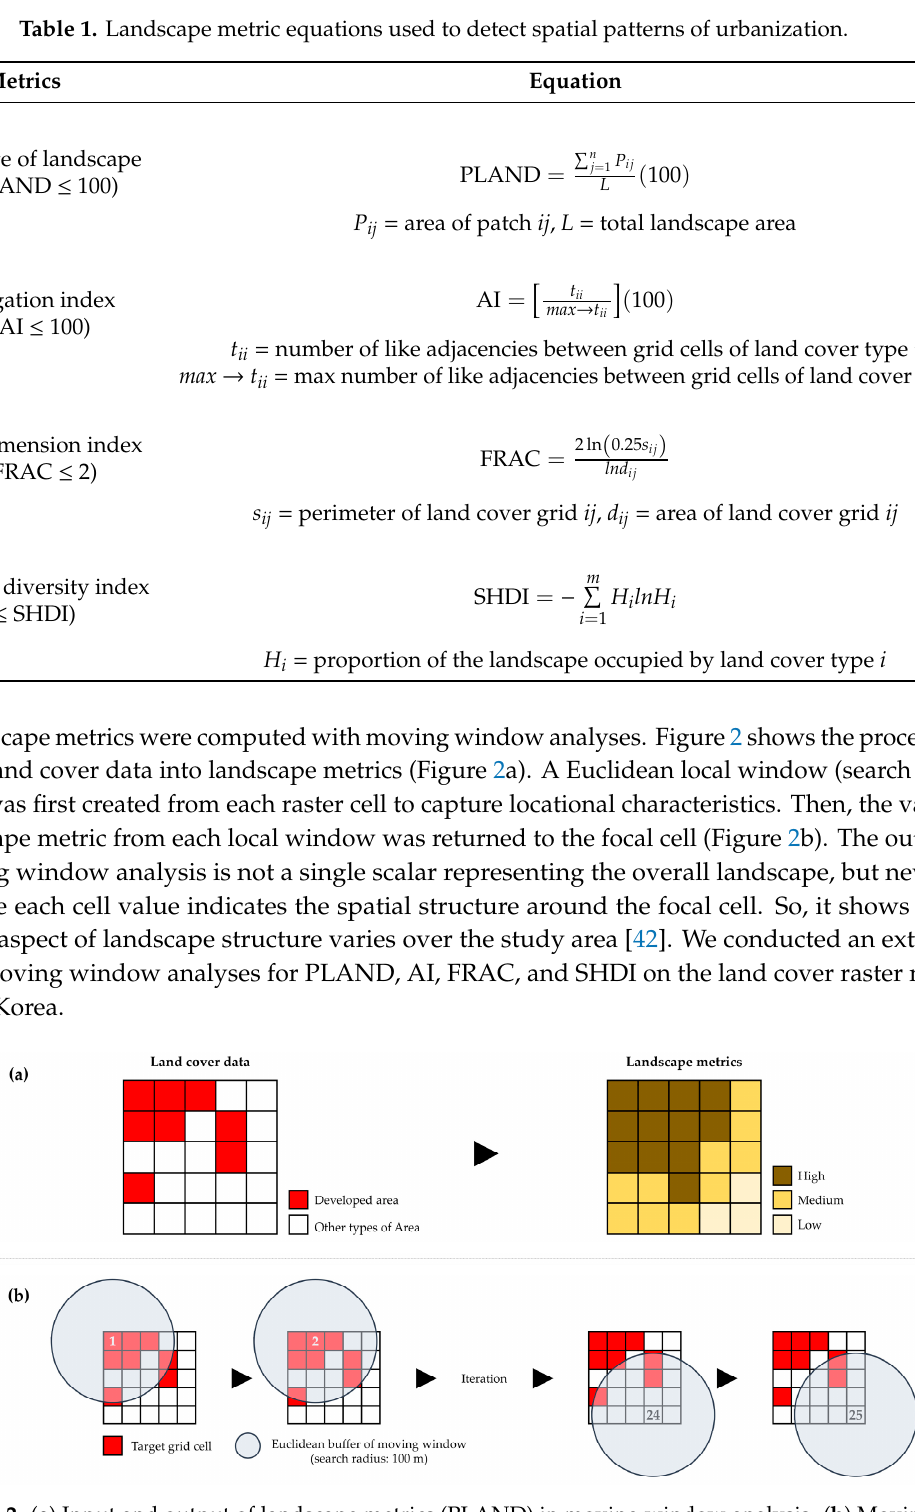
Figure 2. ( a ) Input and output of landscape metrics (PLAND) in moving window analysis. ( b ) Moving windows were applied to calculate the landscape metrics for each grid cell. Euclidean buffers (radius: 100 m) were used to capture locational characteristics.